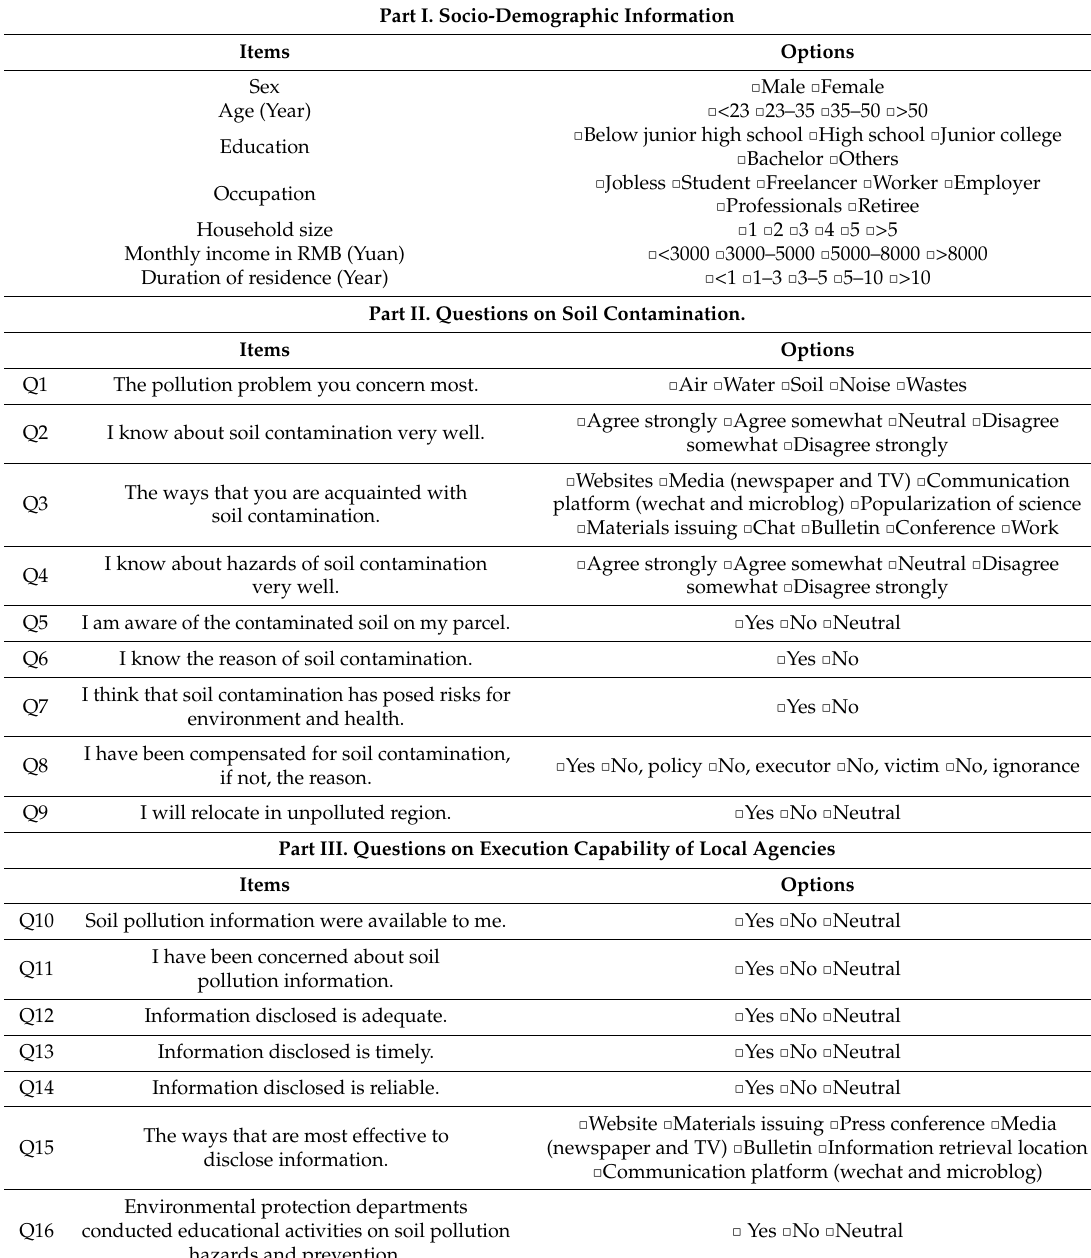
Table A1. Awareness of residents towards soil